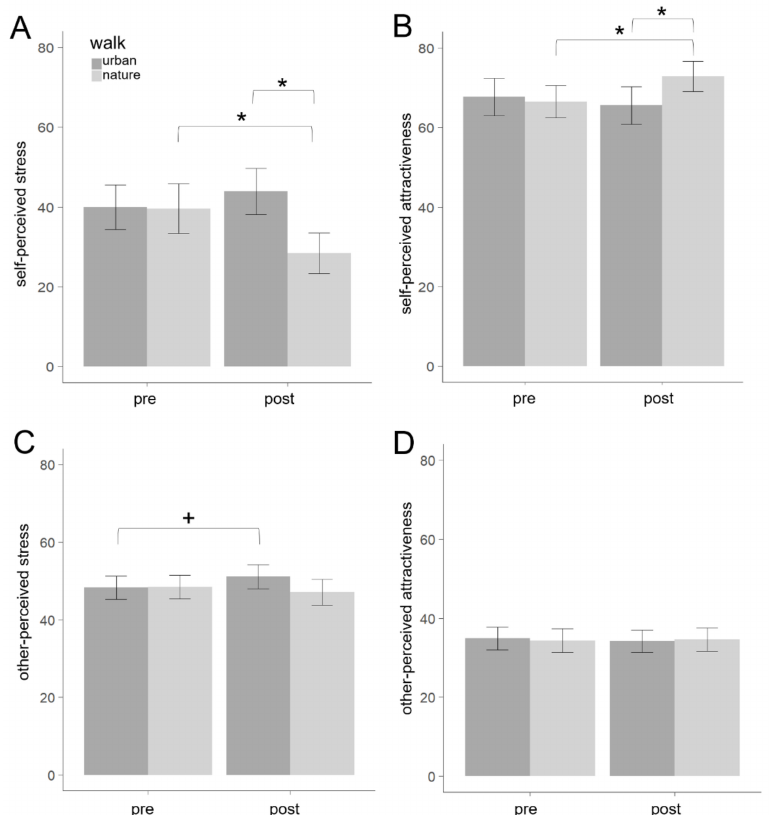
Figure 4. Results of self- ( A , B ) and other-rated ( C , D ) stress and attractiveness before and after urban and nature walks with indication of significance for post-hoc tests. See main text for statistical parameters of the main e ff ects and interactions from the respective 2 × 2 ANOVAs. Note. * p < 0.05, + p =